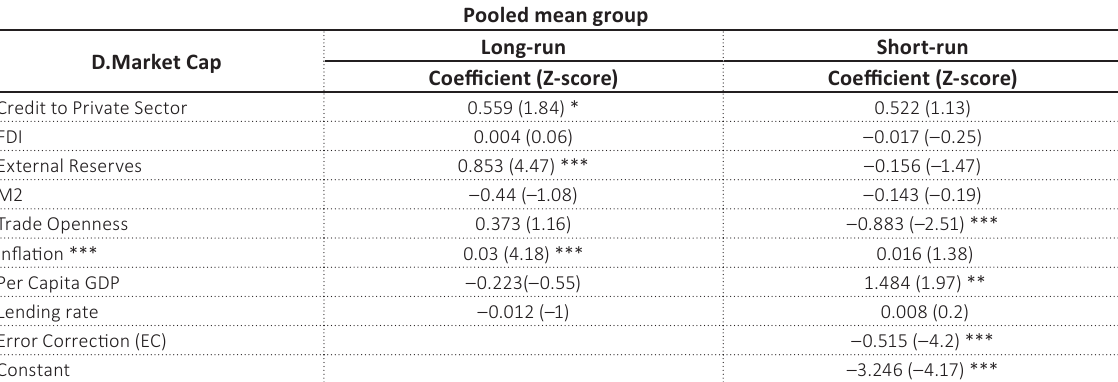
Table 1. Pooled mean group estimator